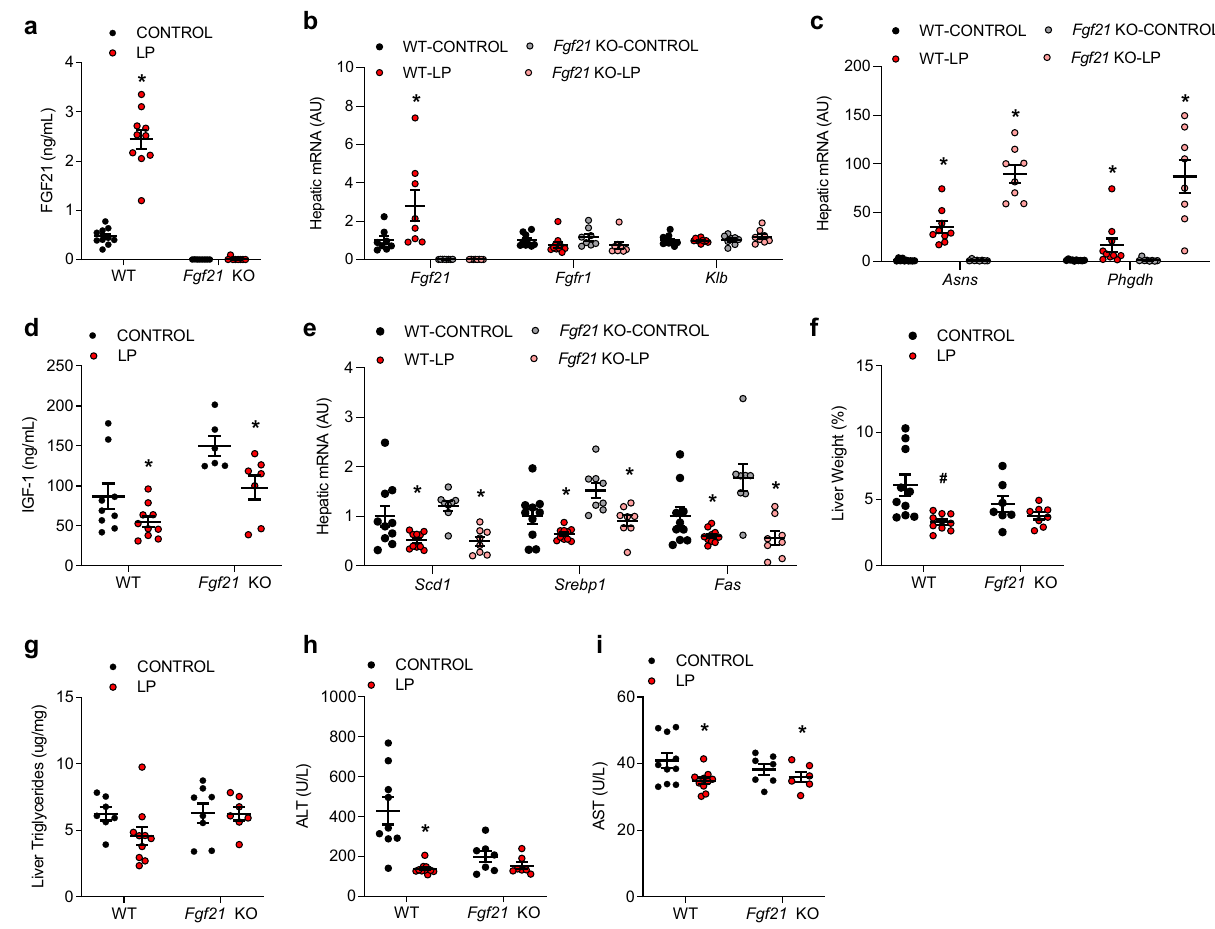
Fig. 5 FGF21-dependent and independent changes in molecular endpoints in the liver at 22 months of age. a Serum FGF21 levels collected at sacri fi ce at 22 months of age in WT and Fgf21 KO mice on control or LP diets as in Fig. 2 ( n = 8 – 10 mice/group, geno*diet p = 0.01). b Liver mRNA levels for FGF21 related markers as measured via qPCR at 22 months of age ( n = 8 – 10 mice/group, geno*diet Fgf21 p = 0.04, Fgfr1 p = 0.556, Klb = 0.3016). c Liver markers of dietary protein restriction (amino acid biosynthetic genes) as measured via qPCR at 22 months of age ( n = 8 – 10 mice/group; geno*diet Asns p = 0.0001, Phgdh p = 0.001. d Serum IGF1 levels at sacri fi ce at 22 months of age ( n = 8 – 10 mice/group; genotype p = 0.0004, diet p = 0.003, geno*diet p = 0.4567). e Liver mRNA expression for hepatic lipogenic genes as measured via qPCR at 22 months of age ( n = 8 – 10 mice/group; Scd1 diet p = 0.001 geno*diet p = 0.553, Srebp1 diet p = 0.001, geno*diet p = 0.89, Fas diet p = 0.001 geno*diet p = 0.2395. f Liver weight as a percentage of body weight at sacri fi ce